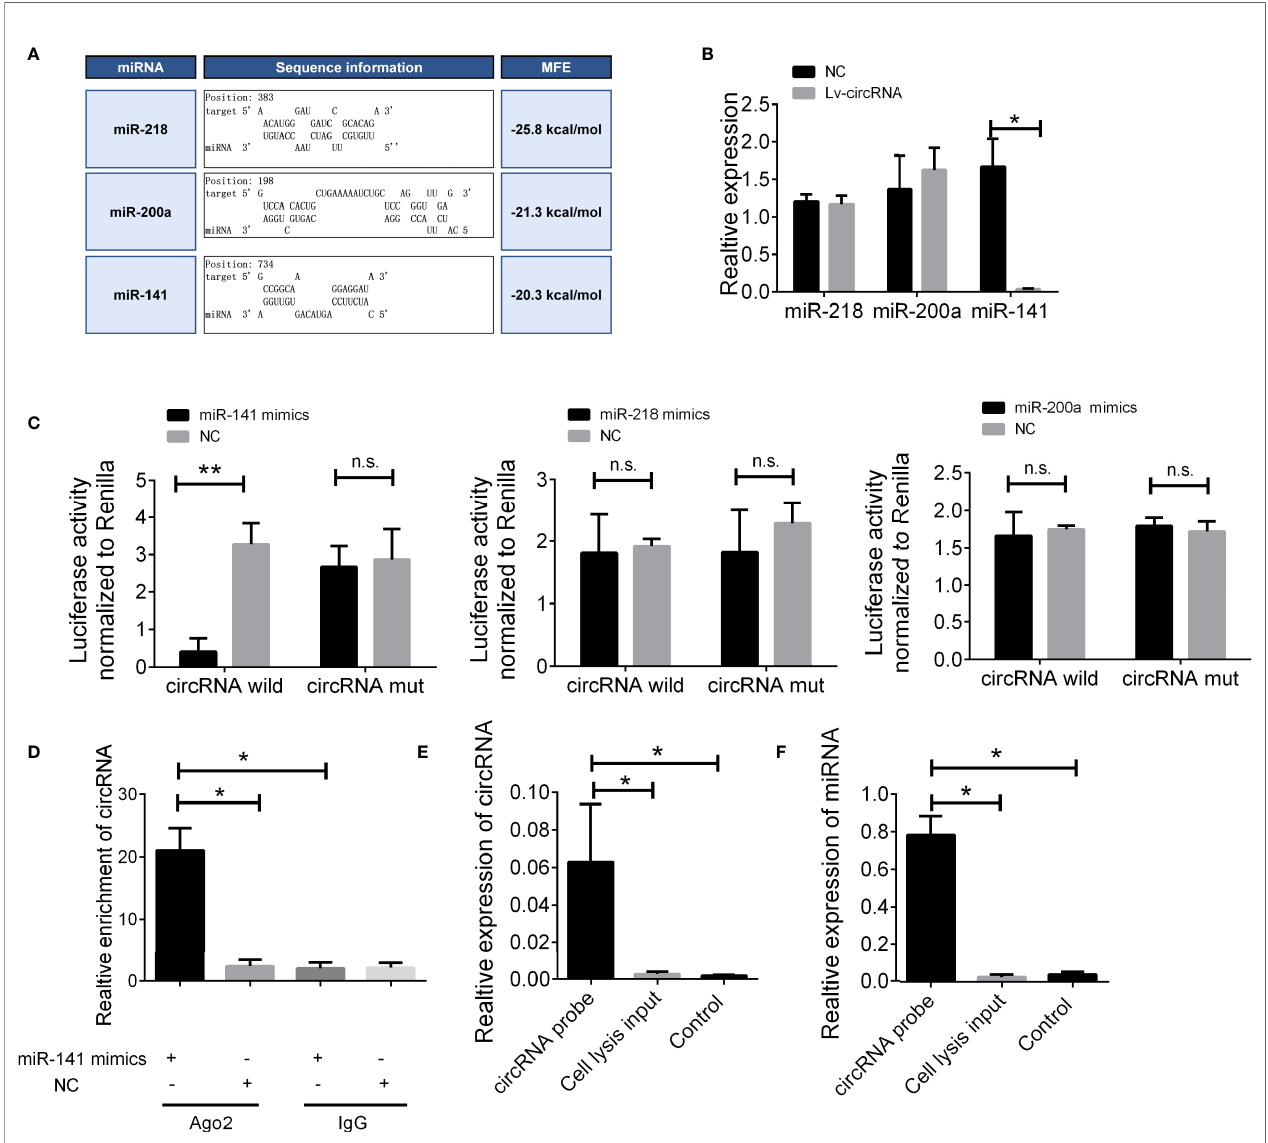
FIGURE 4 | The circ_0032822 could be bound by miR-141. (A) Potential miRNA prediction. (B) Relative expression of miRNA in cells treated with circ_0032822 overexpression lentivirus. (C) Dual-luciferase reporter assay in cells treated with circ_0032822 and candidate miRNA mimics. (D) RIP analysis showed that circ_0032822 was abundantly pulled down by anti-Ago2 antibodies when transfected with miR-141 mimics, compared to the NC or IgG group. (E, F) Biotin-coupled probe pull down assay con fi rmed that miR-141 was effectively enriched by circ_0032822. Data were presented as plot of the mean with SEM. * indicated P < 0.05, ** indicated P < 0.01, n.s., no signi fi